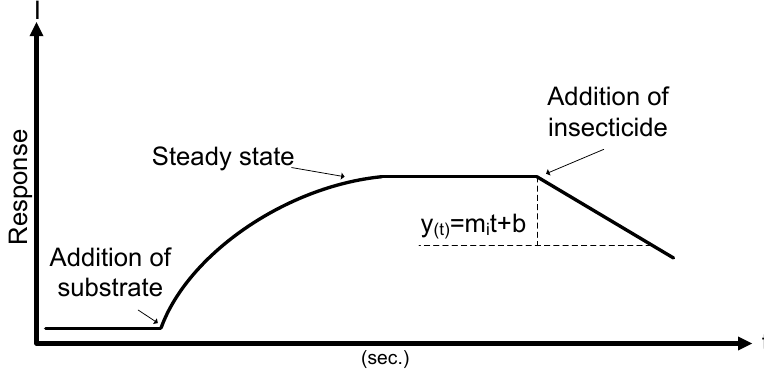
Figure 3. Protocol of enzyme inhibition in the steady-state to measure the inhibition rate is determined by measuring the slope m response. The k p